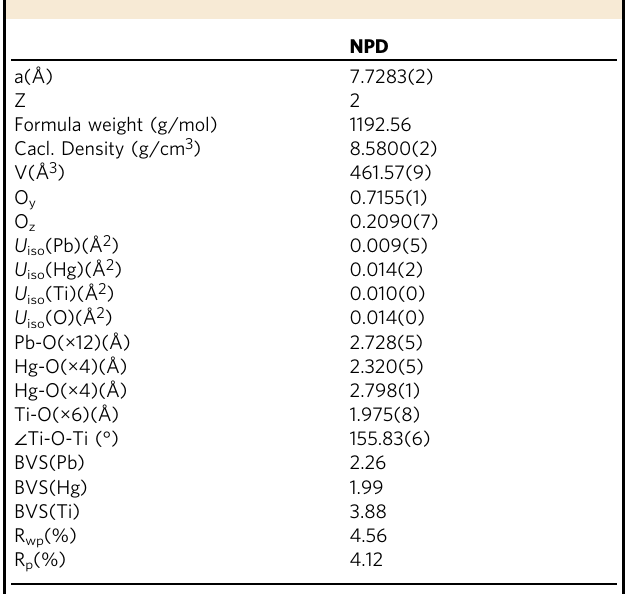
Table 1 Re fi ned structure parameters of PHTO based on NPD data collected at 295 K.